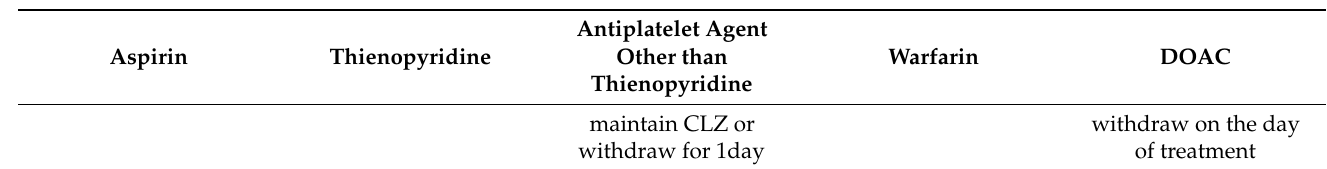
withdraw on the day of treatment